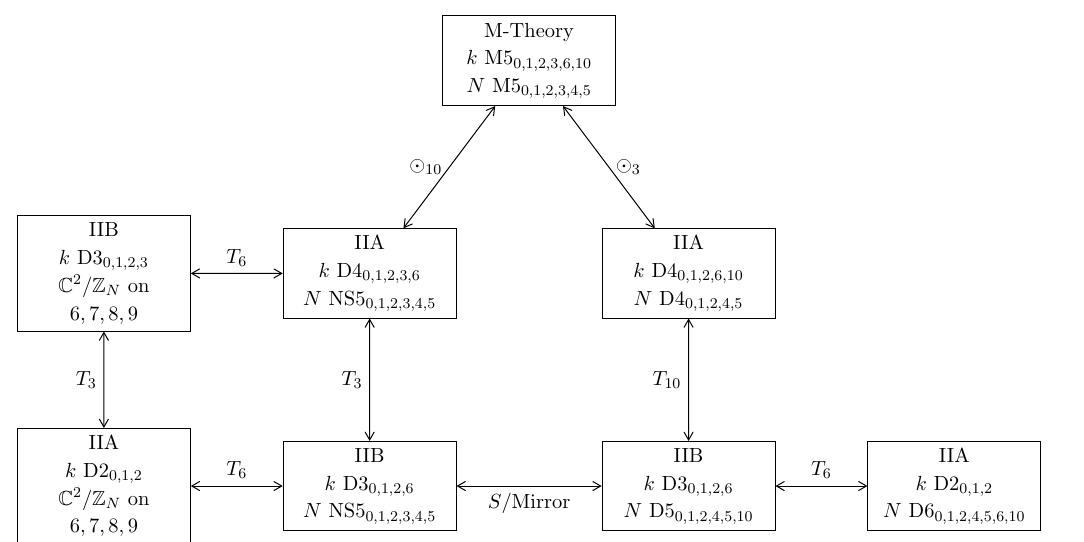
Figure 1 . Summary of the dualities. The top node is the M-theory node, the second line contains the 4d theories (plus the D4/D4) and the third line the 3d theories. The symbol (cid:12) means that we shrink the associated circle to zero